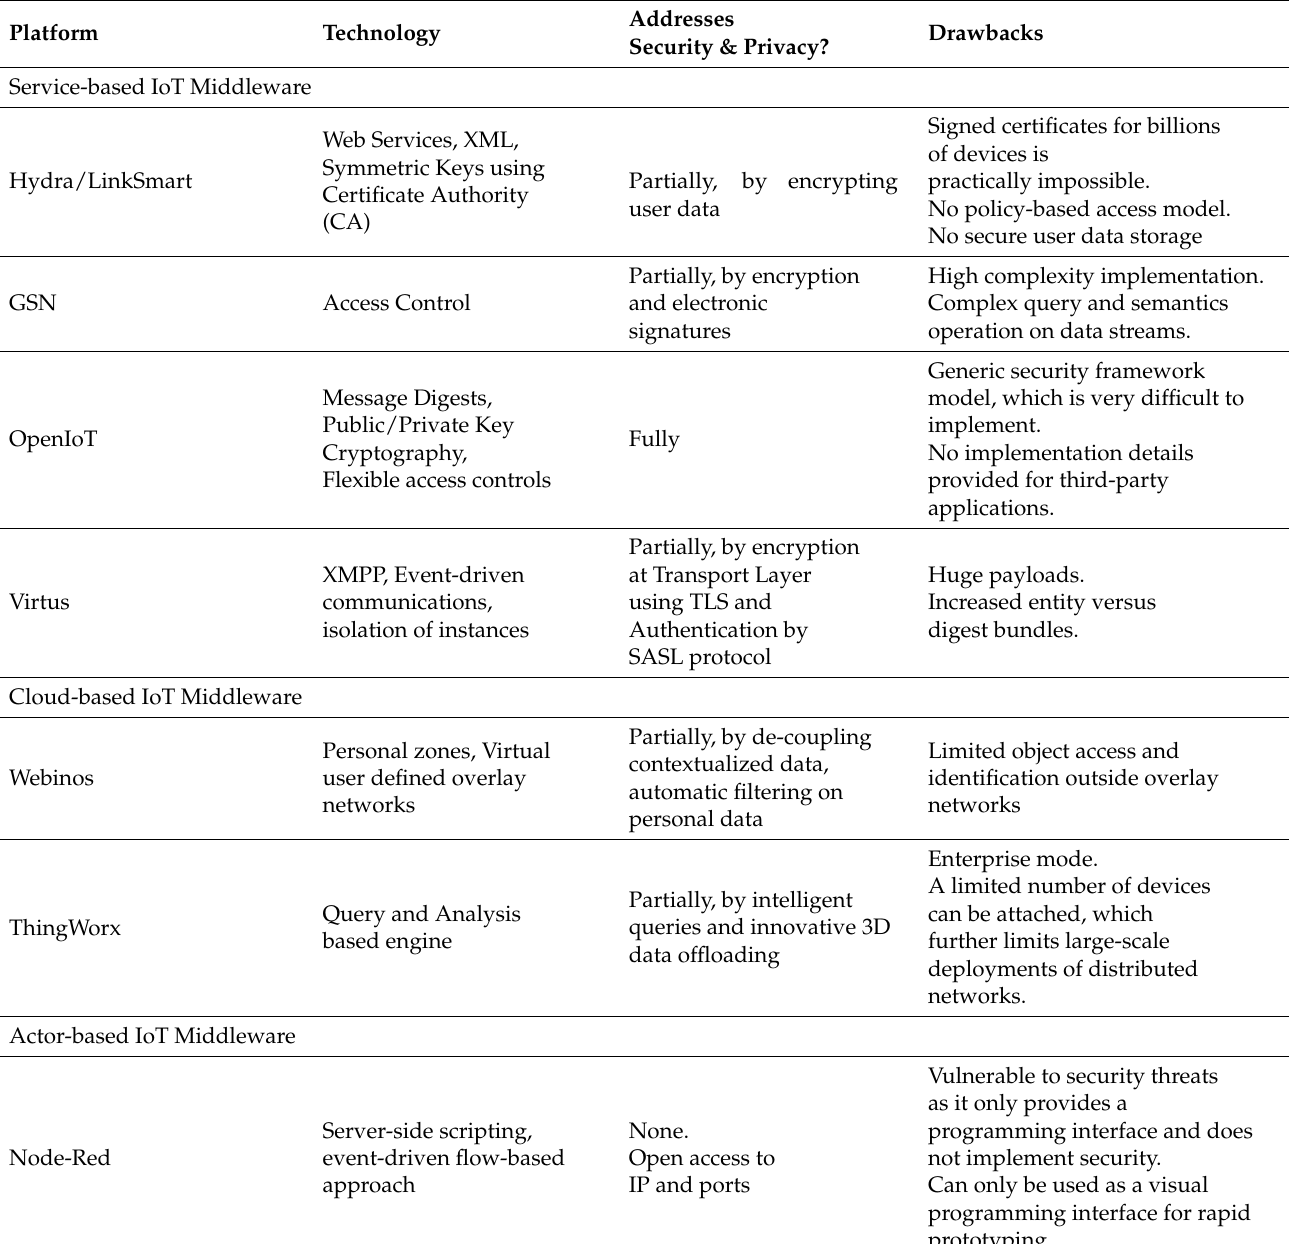
Table 9. Middleware services/platforms and their associated security